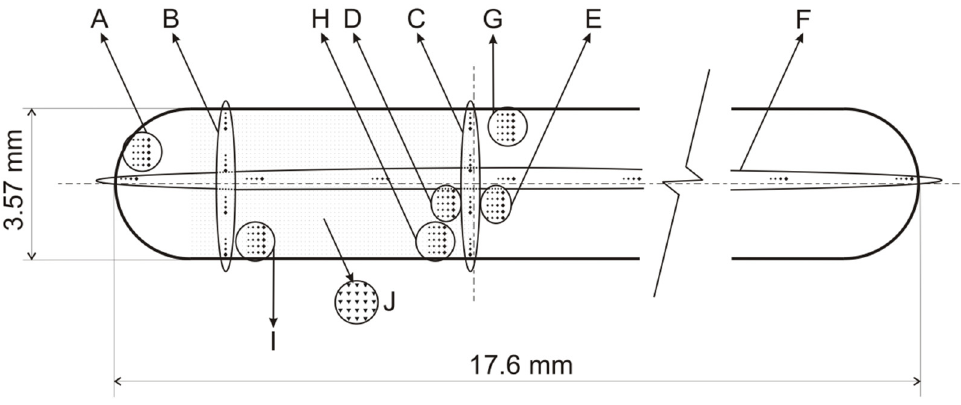
Figure 5. Schematic representation of nano-hardness and micro-hardness measurement areas on sample ε 10 .